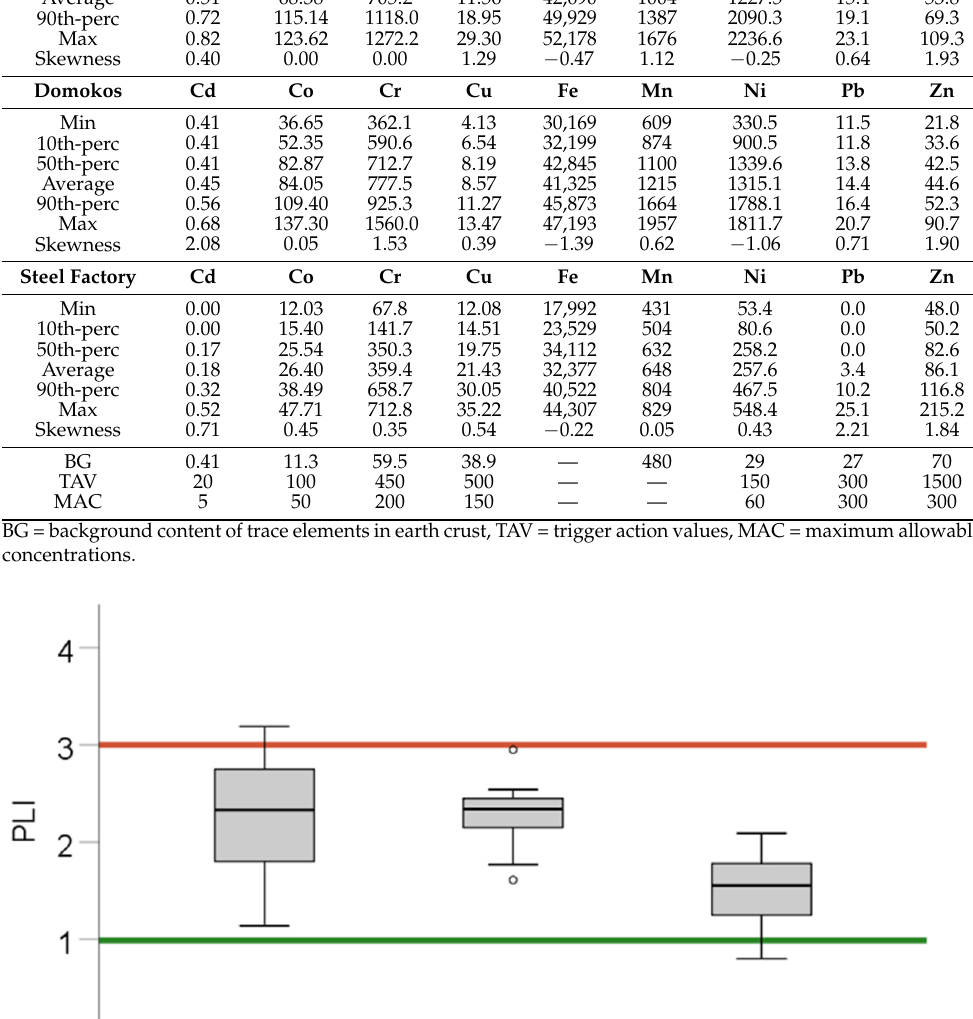
Figure 2. Pollution load index of the soils obtained from Eretria, Domokos and the industrial area of Volos (near the steel factory). Circles and asterisks denote outlier values.